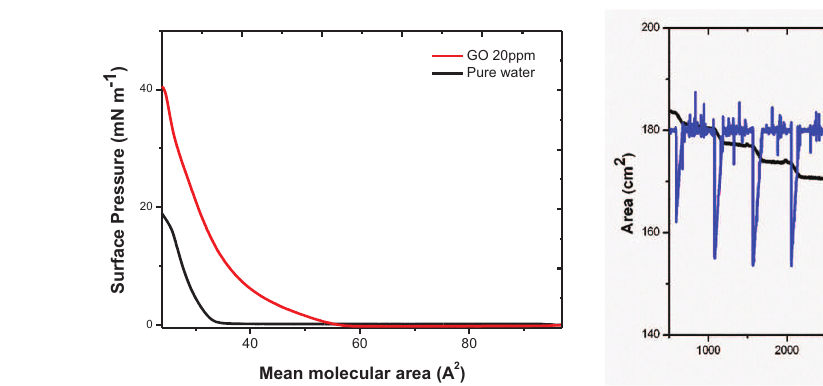
FIGURE 1 | (Left panel) Π –a isotherms of ODA monolayers in pure water and on an aqueous dispersion of 0.02mgmL − 1 GO. (Right panel) The black curve corresponds to the trough area covered by the hybrid ODA–GO Langmuir film